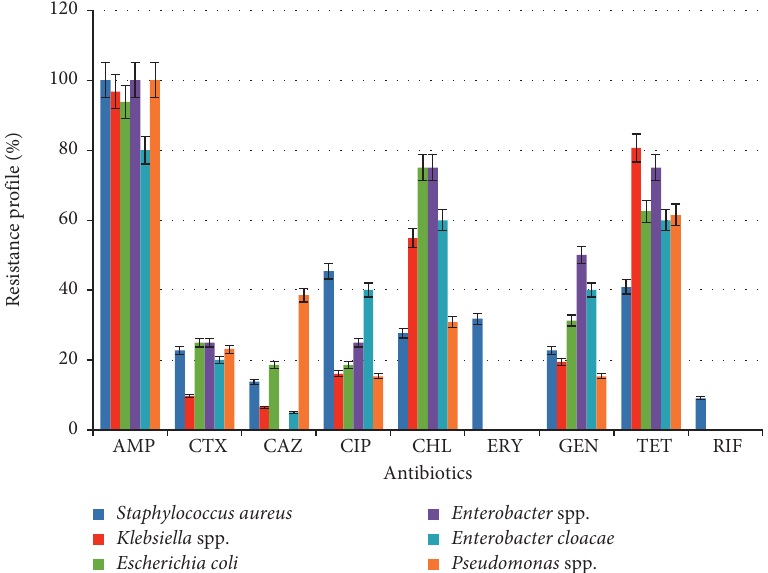
Figure 2: Resistance patterns of pathogenic bacteria isolated. Table 4: Prevalence of multidrug resistance among different bacterial